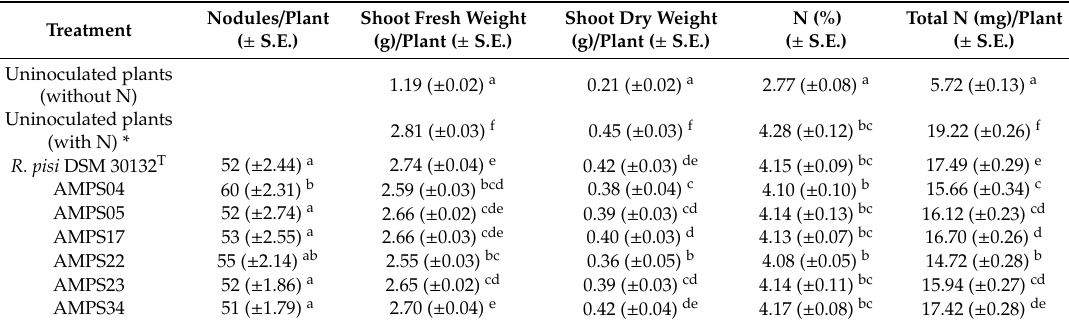
Table 2. E ff ectiveness of selected strains on Pisum sativum